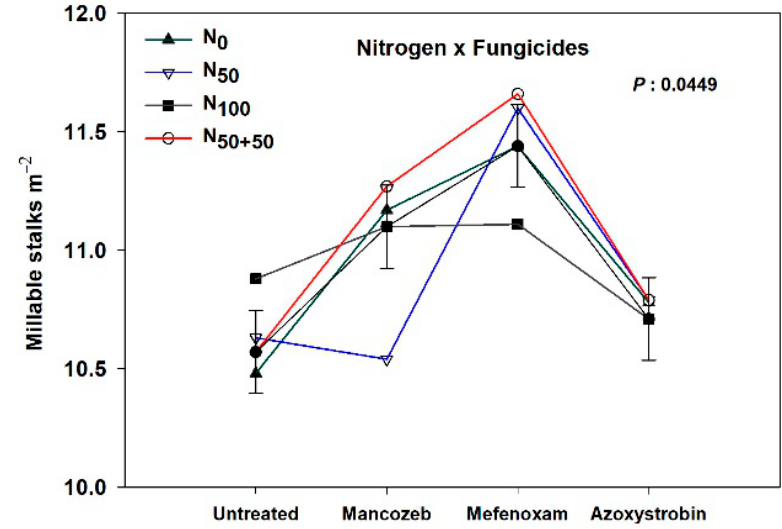
Figure 4. Interaction effects of nitrogen × fungicide on sugarcane millable stalks in 2015 plant crop. Error bars represent standard error of the mean.